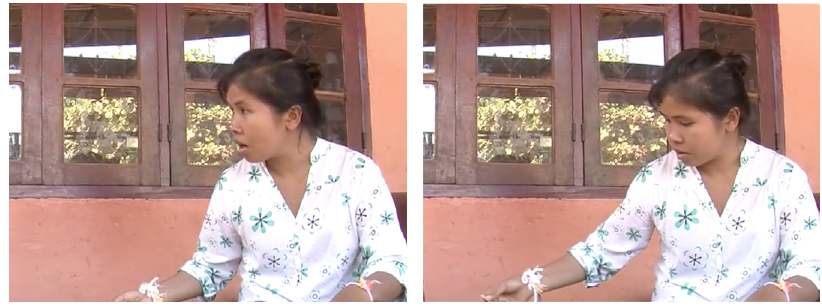
Figure 2. The speaker’s facial expression during two different repair initiating turns (T0). The left panel illustrates a raising of the eyebrows during a repair initiator haa2 ‘huh?’ and would be coded as “yes”. The right panel illustrates no easily noticea- ble facial action and would be coded as